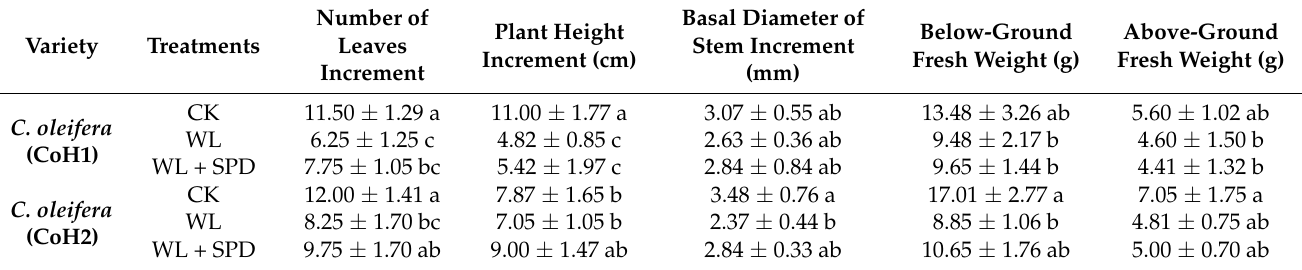
Table 2. Variations of the phenotypic traits in C. oleifera seedlings under WL and treated with exogenous